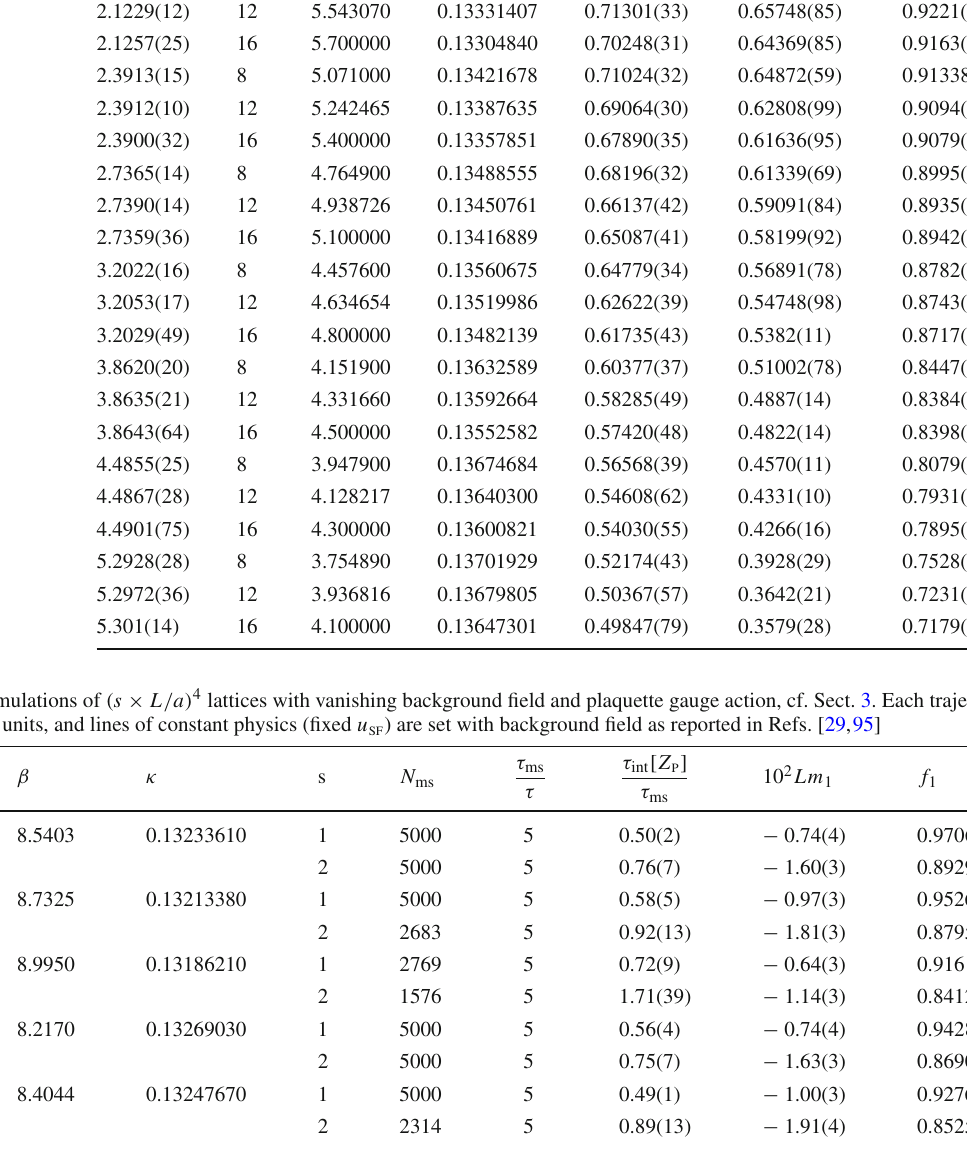
Table 8 Results for Z in the GF scheme